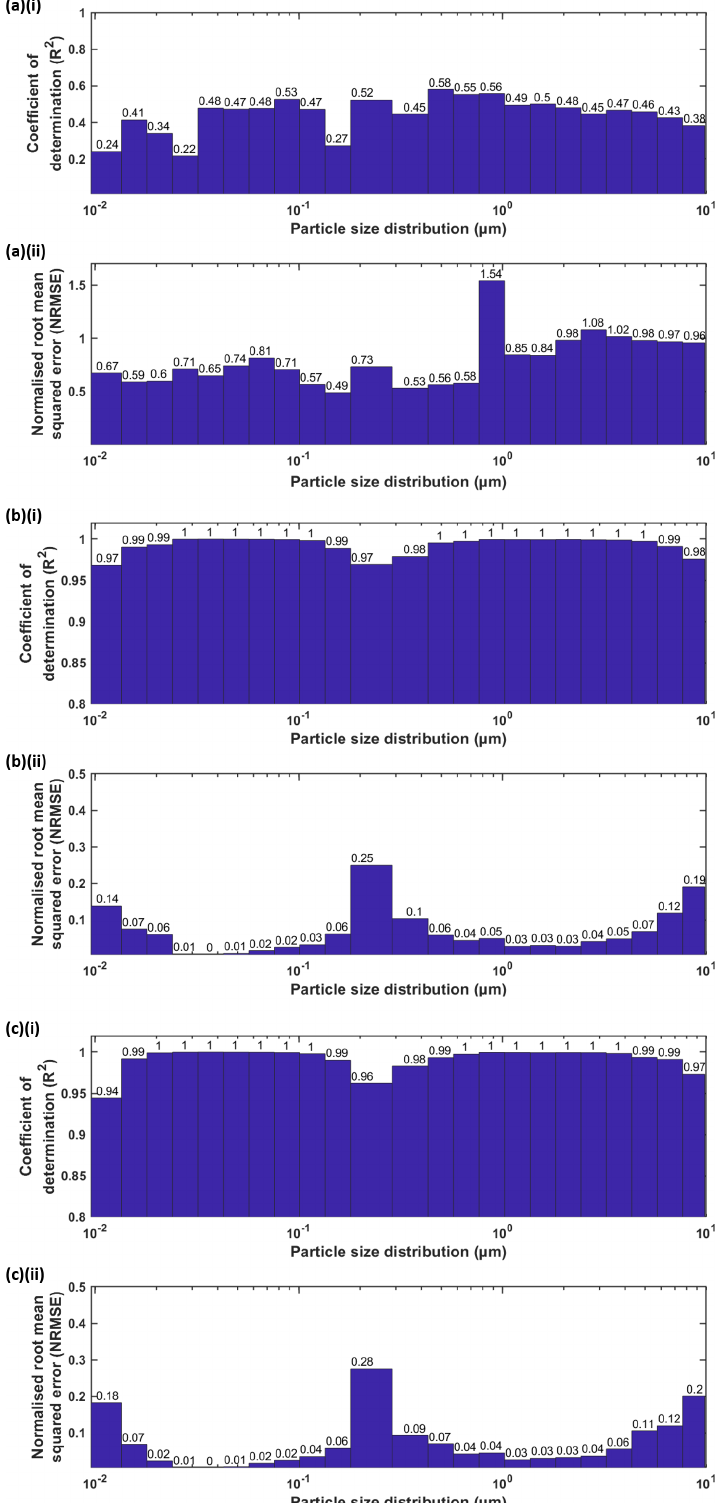
Figure 8. Bar chart showing the evaluation of the FFNN approach with (a) only meteorological parameters (approach 1, FFNN–met), (b ) par- ticle size distribution itself (approach 2, FFNN–PSD), and (c) both particle size distribution and meteorological parameters (approach 3) as inputs. The evaluation metrics for the proposed method include the (i) coefficient of determination ( R 2 ) and (ii) normalised root-mean-square error